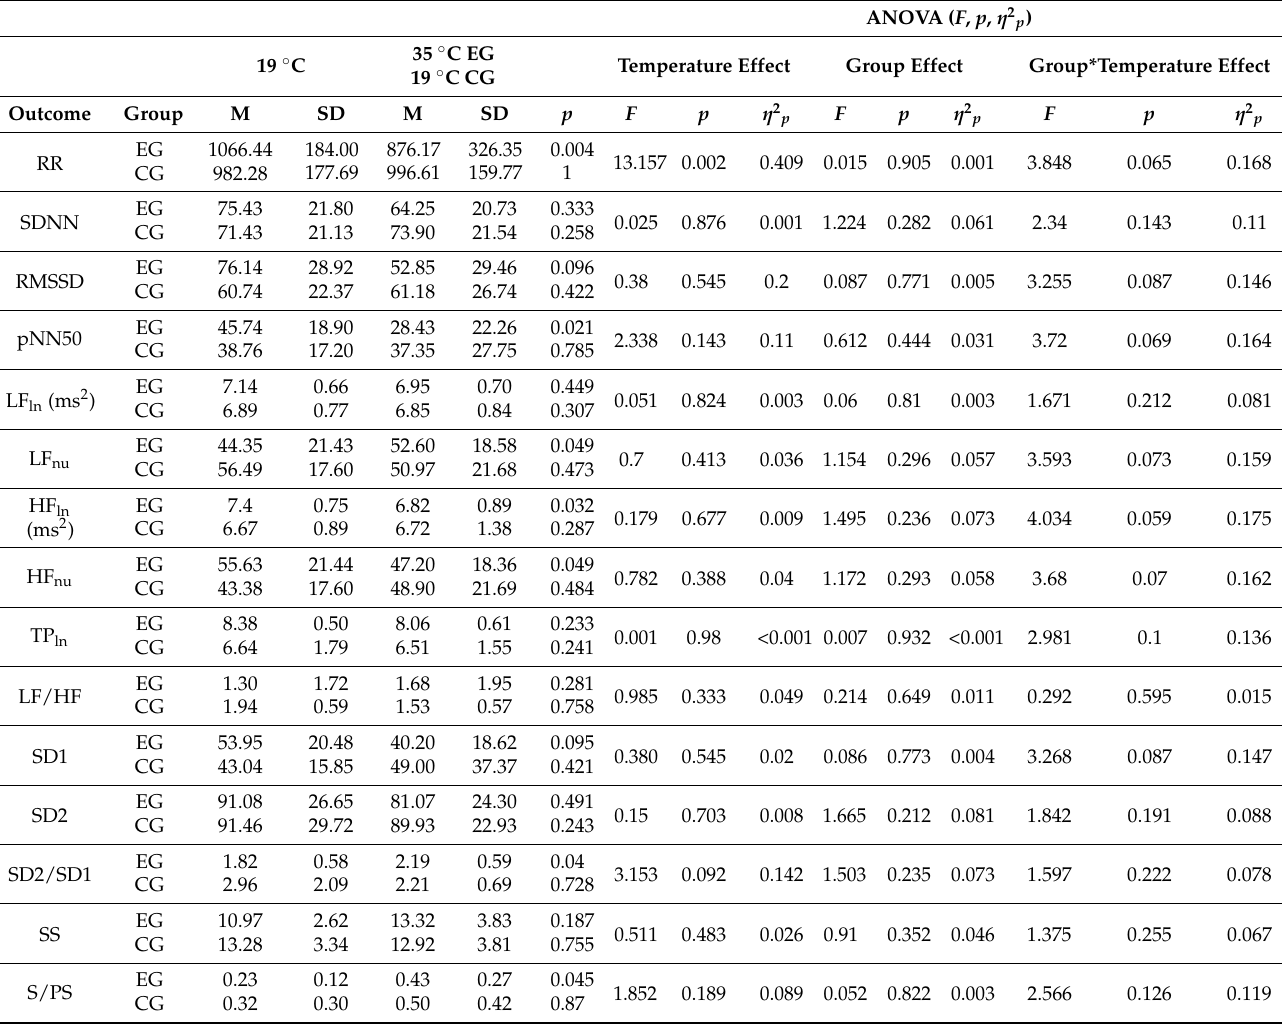
Table 2. Differences on heart rate variability depending on ambient temperature in experimental and control groups during first 5 minutes of measurement.